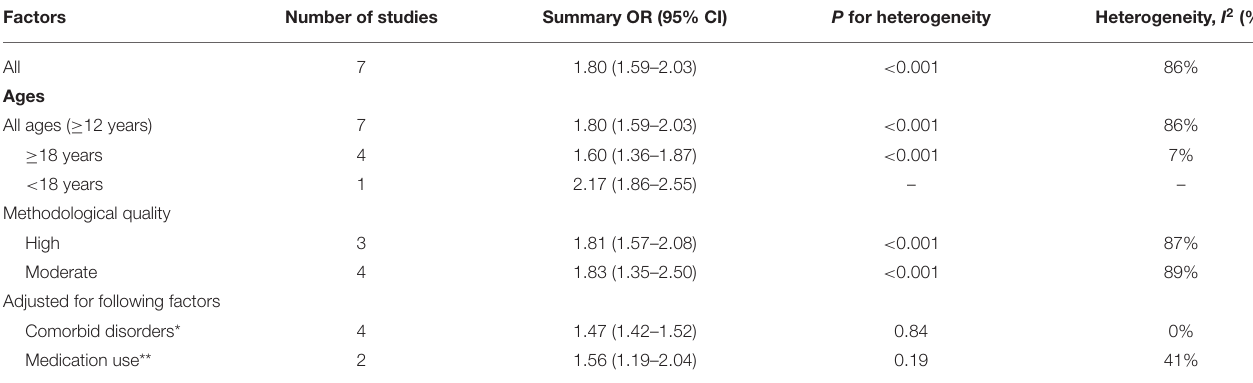
TABLE 3 | Association between asthma and migraine in subgroup meta-analysis by various